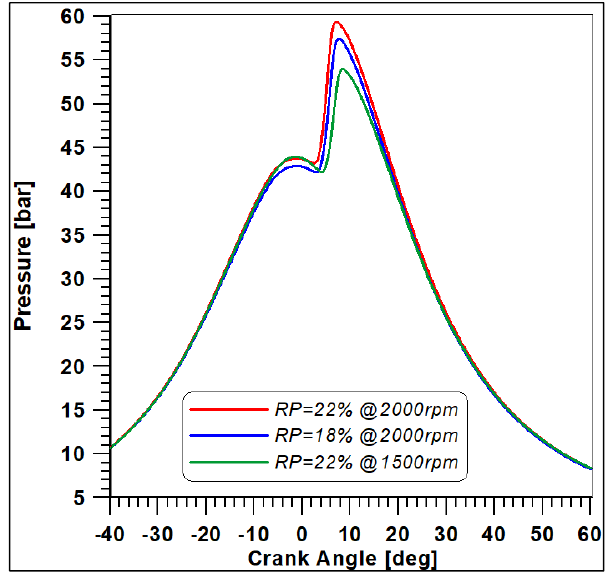
Figure 13. Comparison of in-cylinder pressure curves varying RP and speed.